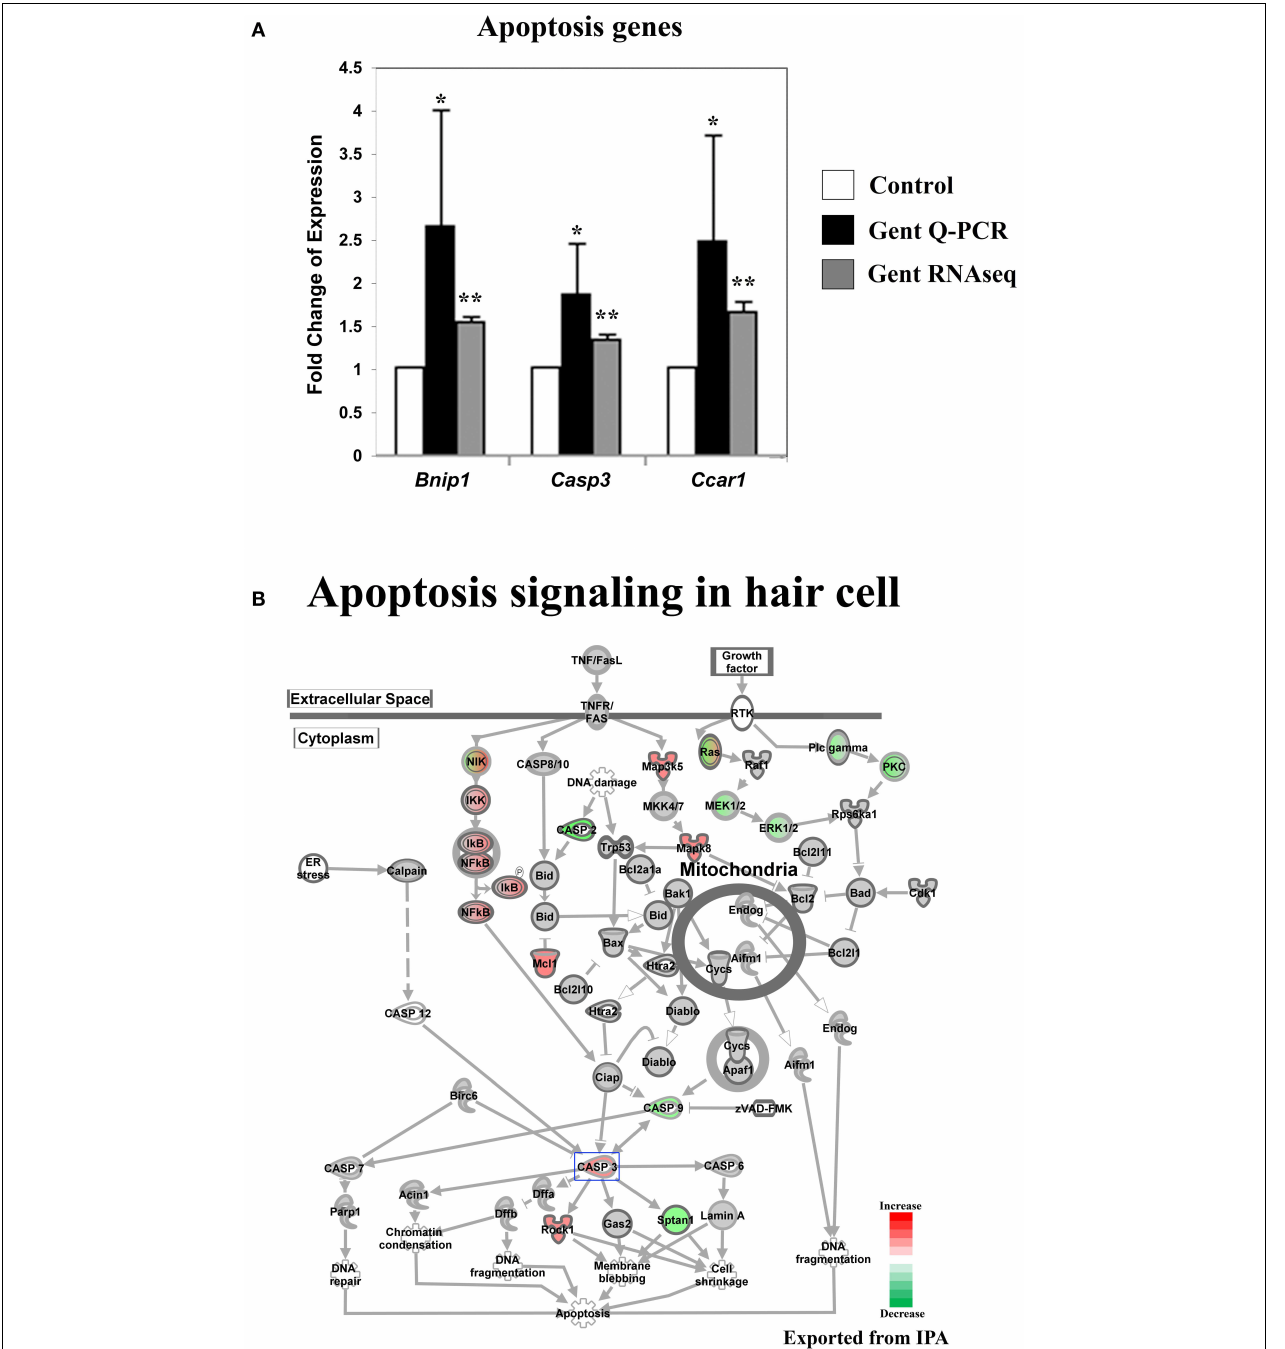
level. Only genes with significant expression changes are colored. Red, increased expression; green, decreased expression relative to control; half red-half green, indicates nodes with multiple genes with some genes upregulated and some genes downregulated. Genes validated and discussed in the text are boxed in the corresponding protein pathway